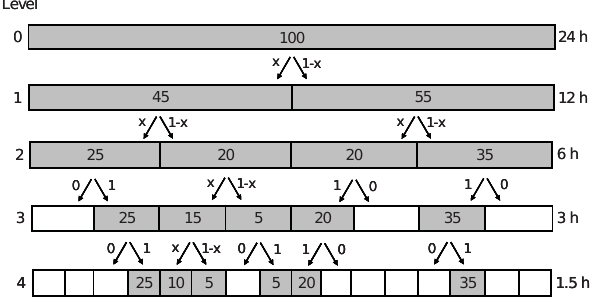
Fig. 2. Scheme of a multiplicative random cascade model (modified after Olsson,